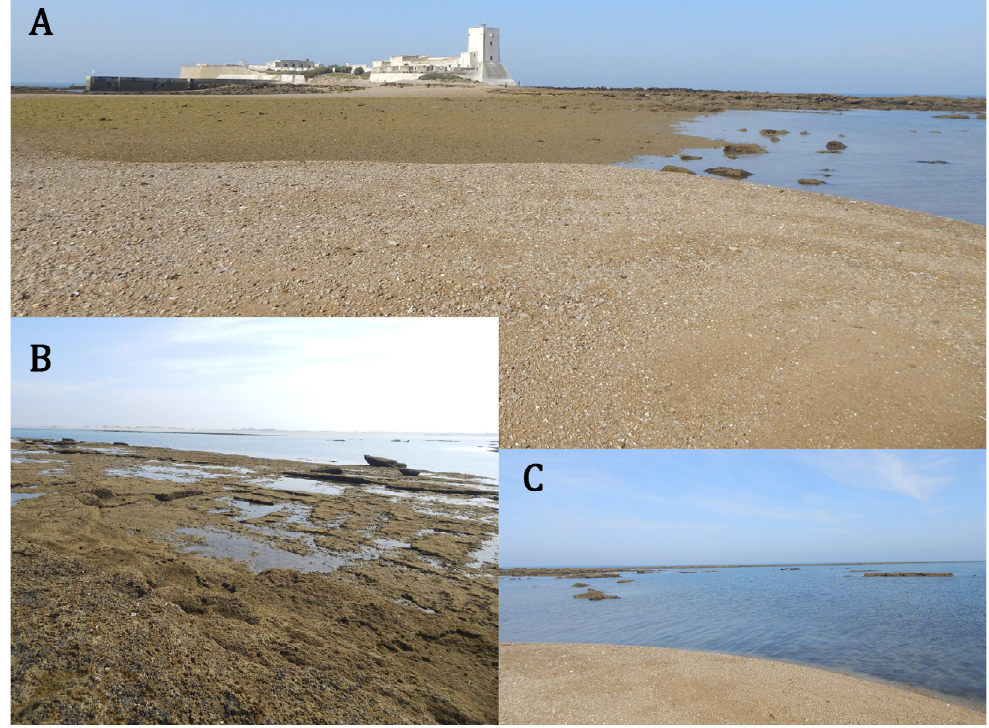
Figure 9. Experimental study from Sancti Petri Castle-point 2 (CSP-North Side). A. Towards the Castle (S.) . B. Towards the mainland (E.). C. Towards the open sea (W.).